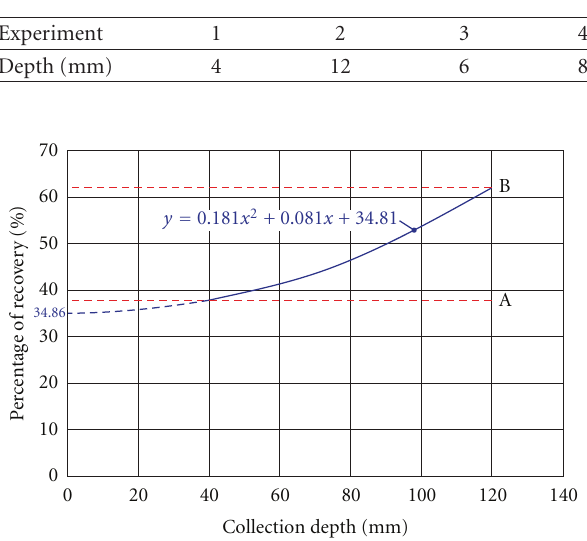
Table 1: Cleaning depths of the experiments.